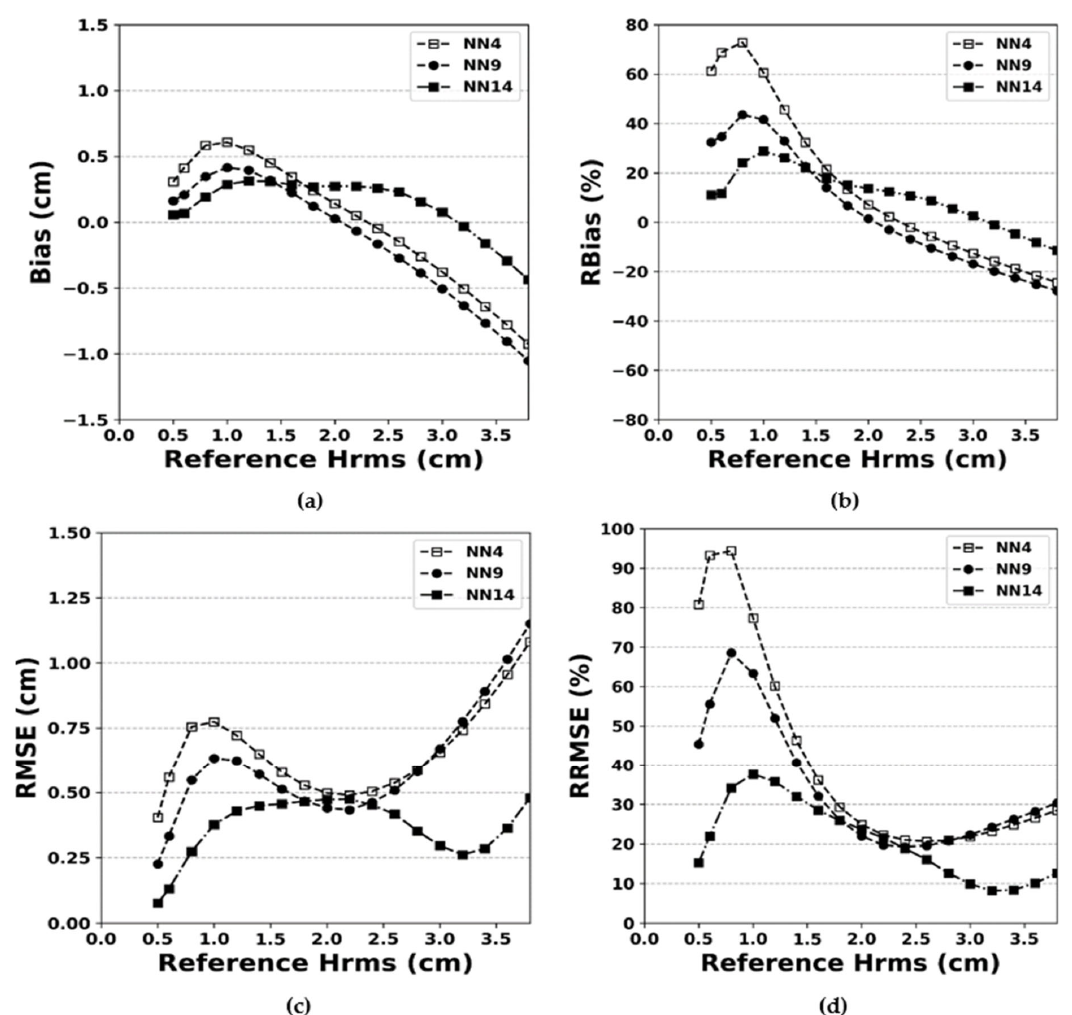
Figure 7. Error evolution on the Hrms estimations as a function of reference Hrms using simulated L-band data. The NNs used are NN4 without a priori information on SSM, NN9 with a priori information on SSM in dry to slightly wet soil conditions, NN14 with a priori information on SSM in very wet soil conditions. ( a ) Bias (estimated Hrms − reference Hrms); ( b ) RBias; ( c ) RMSE; ( d ) RRMSE on Hrms.